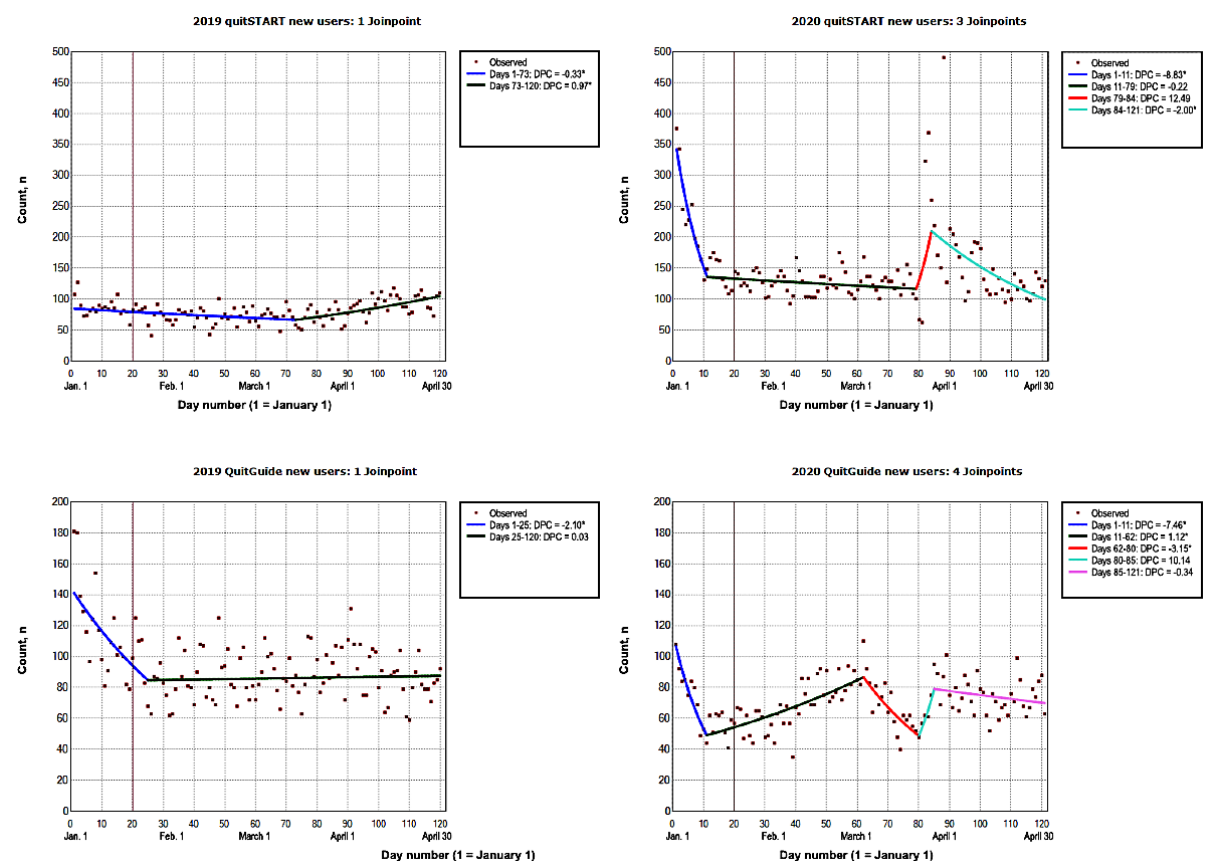
Figure 4. The number of new quitSTART and QuitGuide subscribers from January to April 2019 and 2020. The vertical line represents January 20. On this day in 2020, the first laboratory-confirmed COVID-19 case was identified in the United States. This was reported to the Centers for Disease Control and Prevention on January 22, 2020 [43]. Data on model selection appear in Multimedia Appendix 1. DPC: daily percent change. *The DPC is significantly different from 0 at an α level of